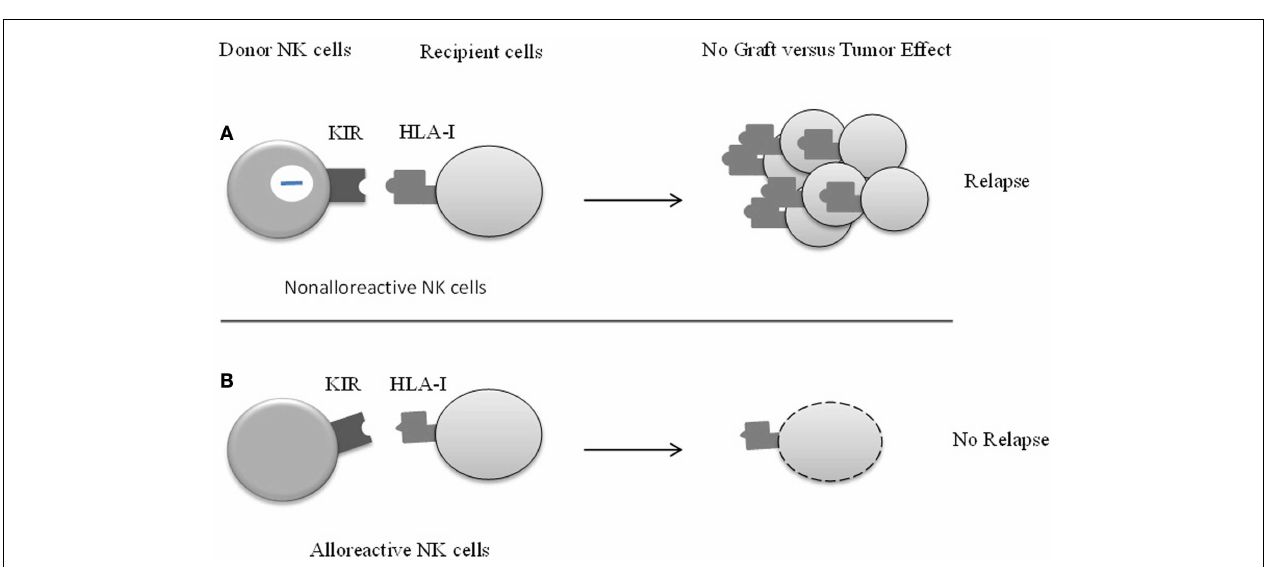
Donor NK cells are non-alloreactive and do not kill recipient’s blasts, which leads to the relapse of patient. (B) The concept and recognition of KIR-ligand incompatibility (also known as KIR-ligand mismatch) has important implications. KIR-mismatch is an independent predictor of survival in patients. Graft versus tumor NK-cell alloreactivity reduces the risk of leukemia relapse, and markedly improves event-free